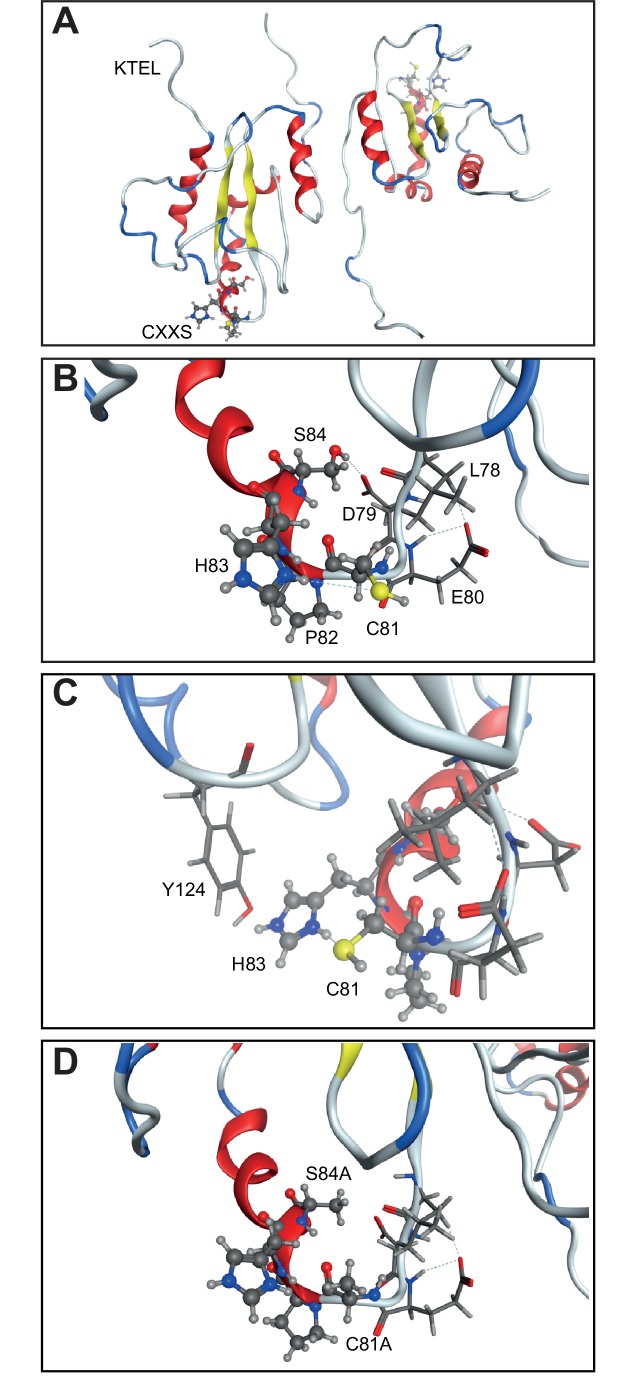
Structure model showing the CXXS (81–84) sequence.(A) The CXXS residues (ball-and-stick model in bottom left and top right) in the AGR2 crystal structure to relate to the position of these vs the KTEL motif. (B) Zoom in of CXXS motif along with residues 78–80 (stick model). S84 forms hydrogen bonded interaction with the carboxylic acid of D79 side chain and backbone carbonyl of L78. (C) Y124 (stick model) from an adjacent loop interacts with H83, which in turn forms a hydrogen bond to C81; providing a good interaction network. (D) AXXA mutant. In silico mutation of C81 and S84 into Alanine illustrates the loss of interactions as compared to that seen in (B) between S84 and L78/D79, and in (C) between Y127-H83-C81.